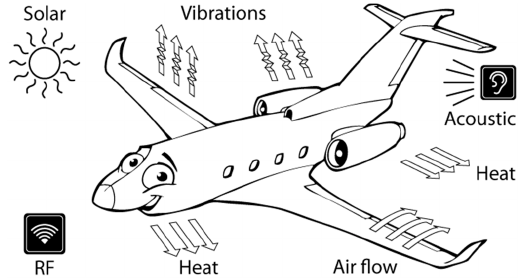
Figure 3. Scheme of an airplane with indicated energy harvesting sources discussed in this work. Figure 2. EH principle of powering autonomous sensor networks with the respective data elaboration and transmission modules.